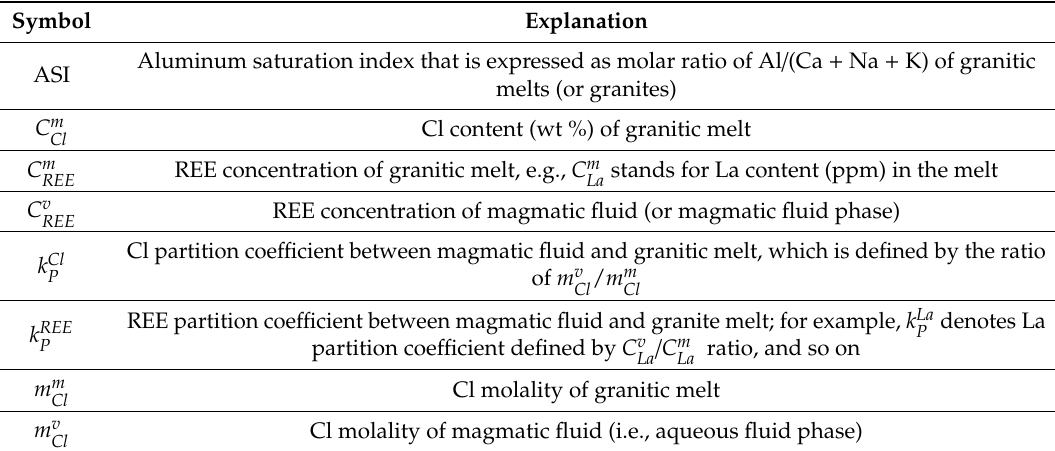
Table 1. Symbols used in this paper. REE: rare earth